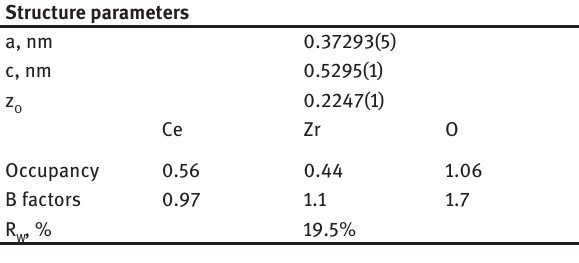
Table 4: Results of Rietveld refinement of Ce calcined at